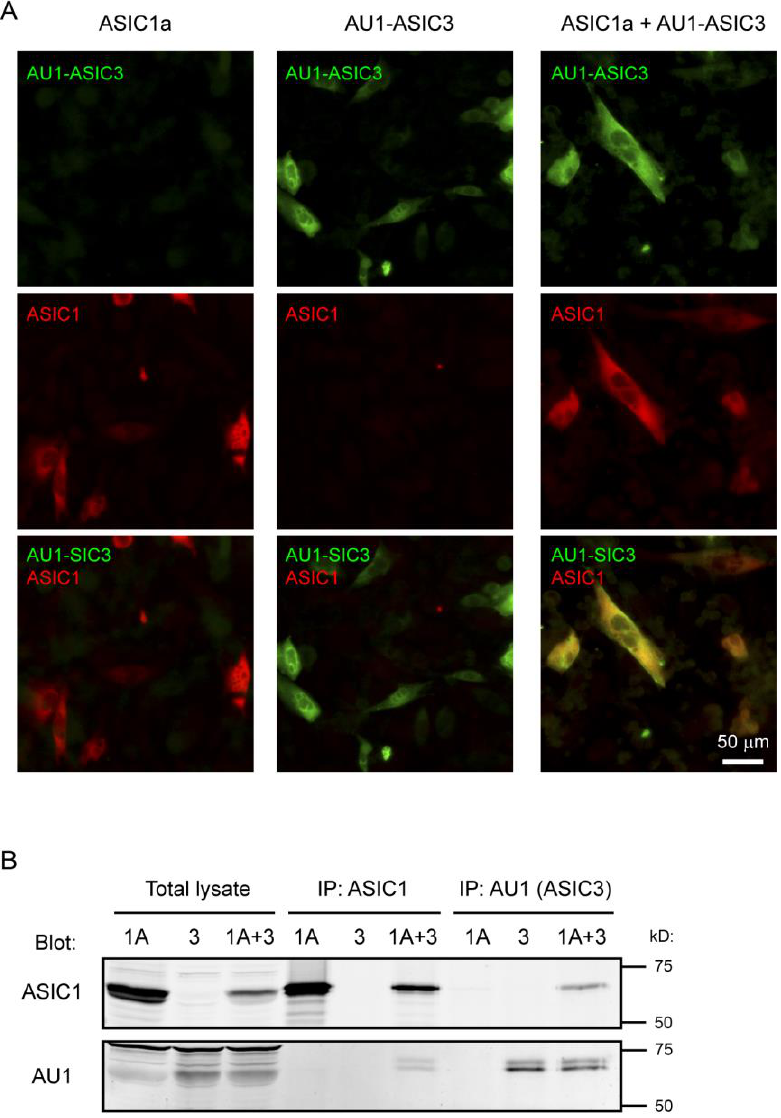
Figure 1. Co-expressed acid-sensing ion channel subunits 1a and 3 (ASIC1a and ASIC3) formed heteromeric complex in Chinese hamster ovary (CHO) cells. ( A ) Immunostaining shows ASIC1 and ASIC3 expression in transfected cells. CHO cells were transfected with ASIC1a, AU1-ASIC3, or ASIC1a + AU1-ASIC3 (1:2 ratio). CHO cells were stained for AU1-ASIC3 (green) and ASIC1 (red) as described in the Materials and Methods section. Note that, when co-transfected into the CHO cell (right panel), most of the ASIC1a expressing cells also were positive for AU1-ASIC3 staining; ( B ) ASIC1a and ASIC3 co-immunoprecipitate from transfected cells. CHO cells were transfected with ASIC1a, AU1-ASIC3, or ASIC1a + AU1-ASIC3 (1:2 ratio). Immunoprecipitation was performed using a goat anti-ASIC1 or goat anti-AU1-ASIC3. Total lysate and immunoprecipitation (IP) fractions were blotted for ASIC1 (rabbit) or AU1-ASIC3 (mouse) as indicated.